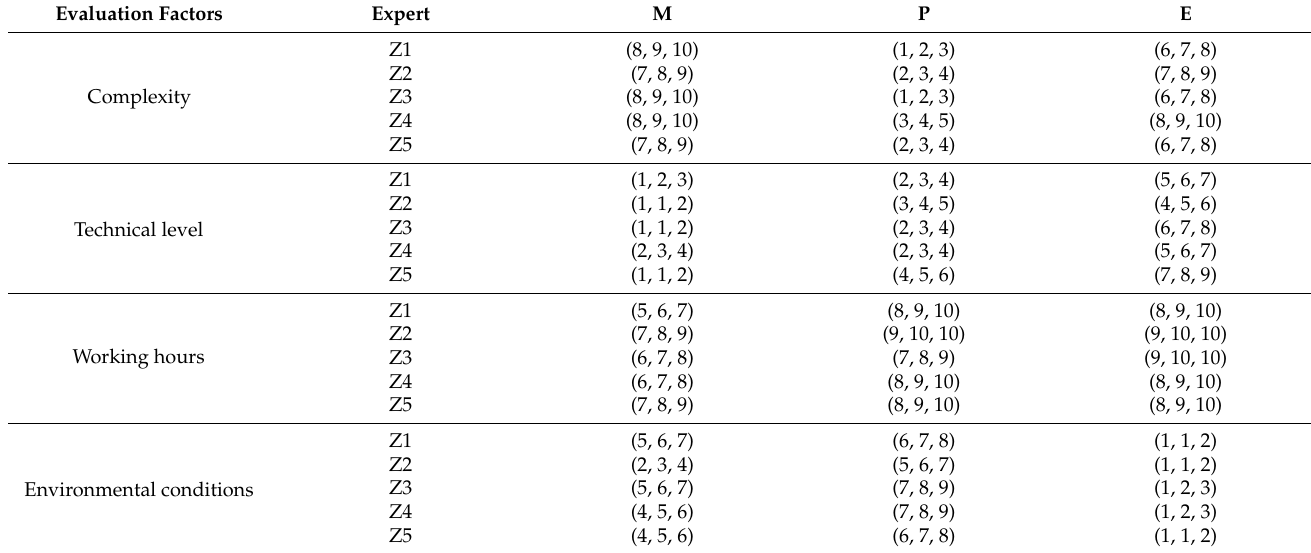
Table 3. Each system expert score results